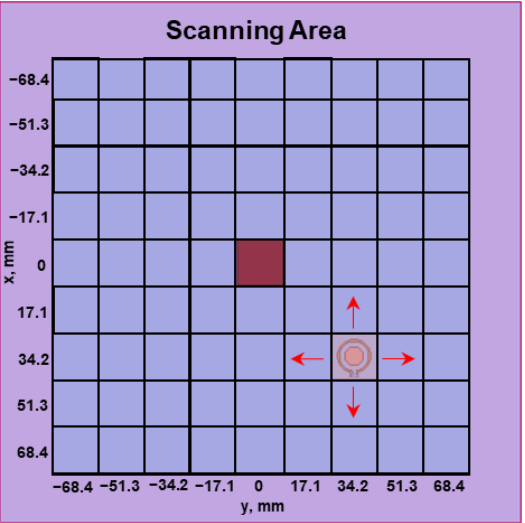
Figure 4. Schematic for the raster scan. A tumor with a volume of 17.1 3 mm 3 was positioned at a depth of 10 mm and (x = 0, y = 0). In the illustration, the sensor is (34.2, 34.2) to obtain the reflection coefficient of the pixel (34.2,